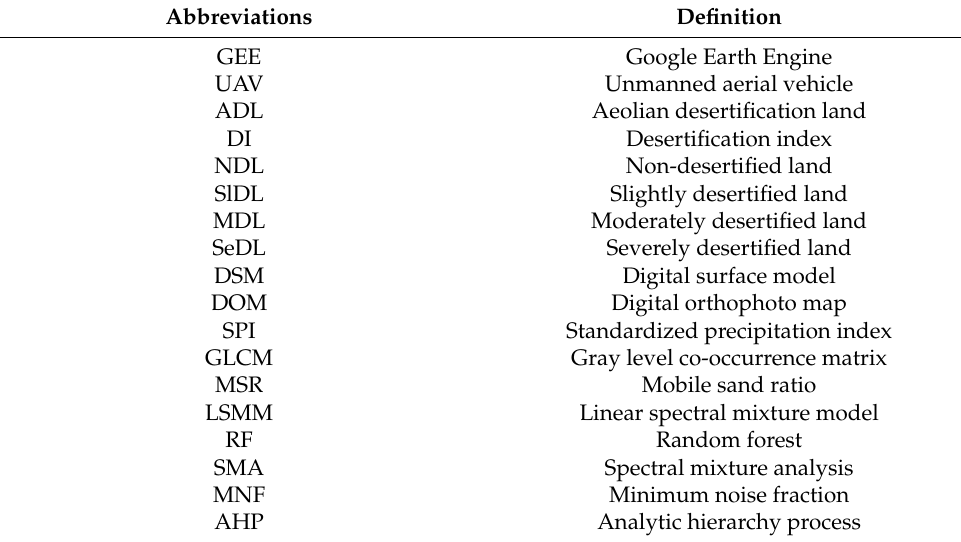
Table A1. Definition of main abbreviations.